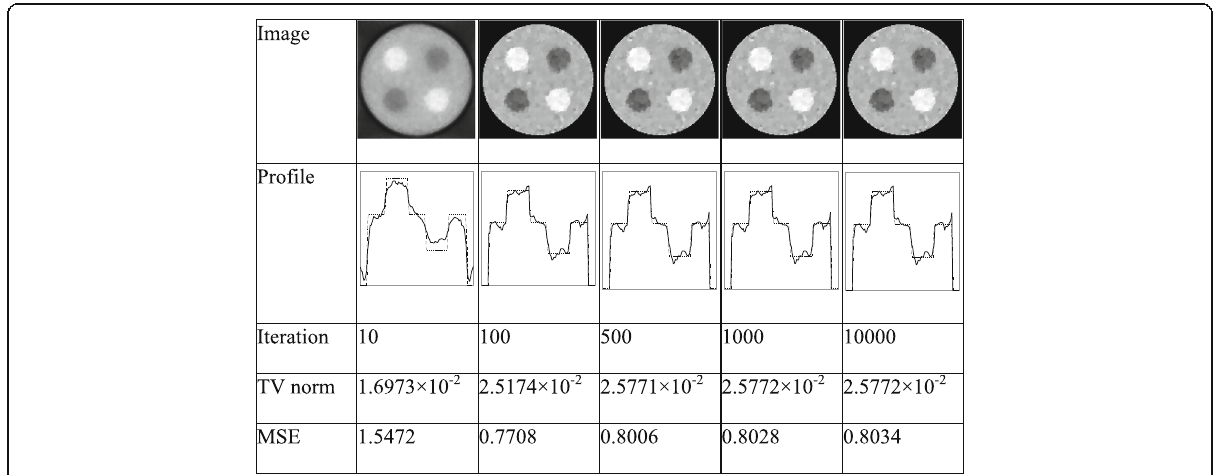
Fig. 3 Reconstructions of emission data using Green ’ s OSL algorithm with β = 1.2